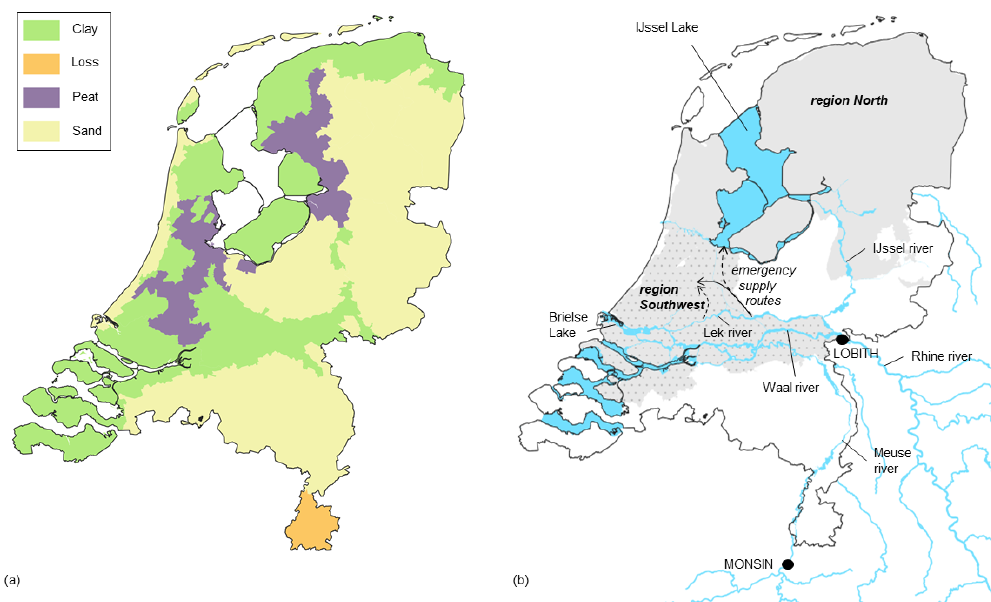
Figure 2. Study area: (a) major soil types of the Netherlands and (b) major rivers, lakes, and water supply routes of the Netherlands and the location of the two focus regions in grey, largely containing peat and clay